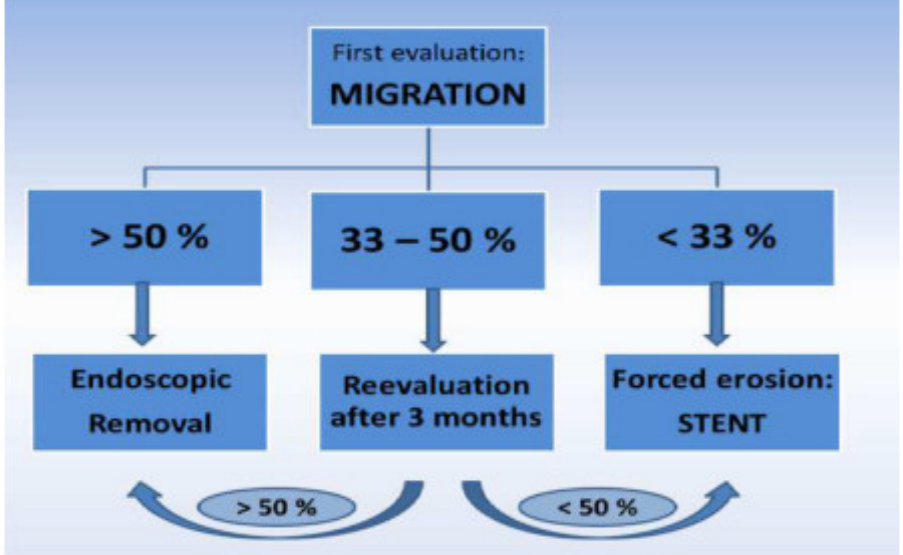
Figure 1. Algorithm for endoscopic gastric band removal.